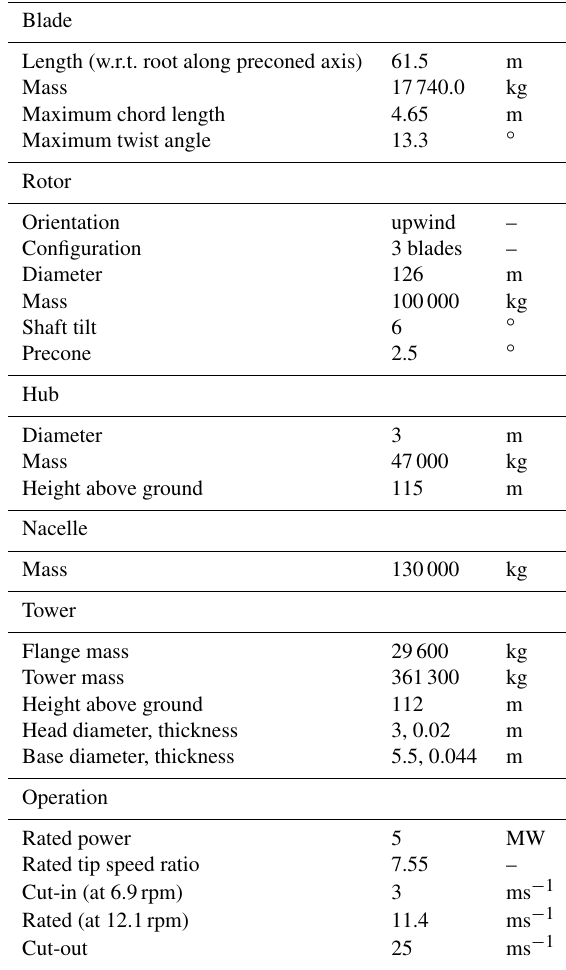
Table 1. Wind turbine